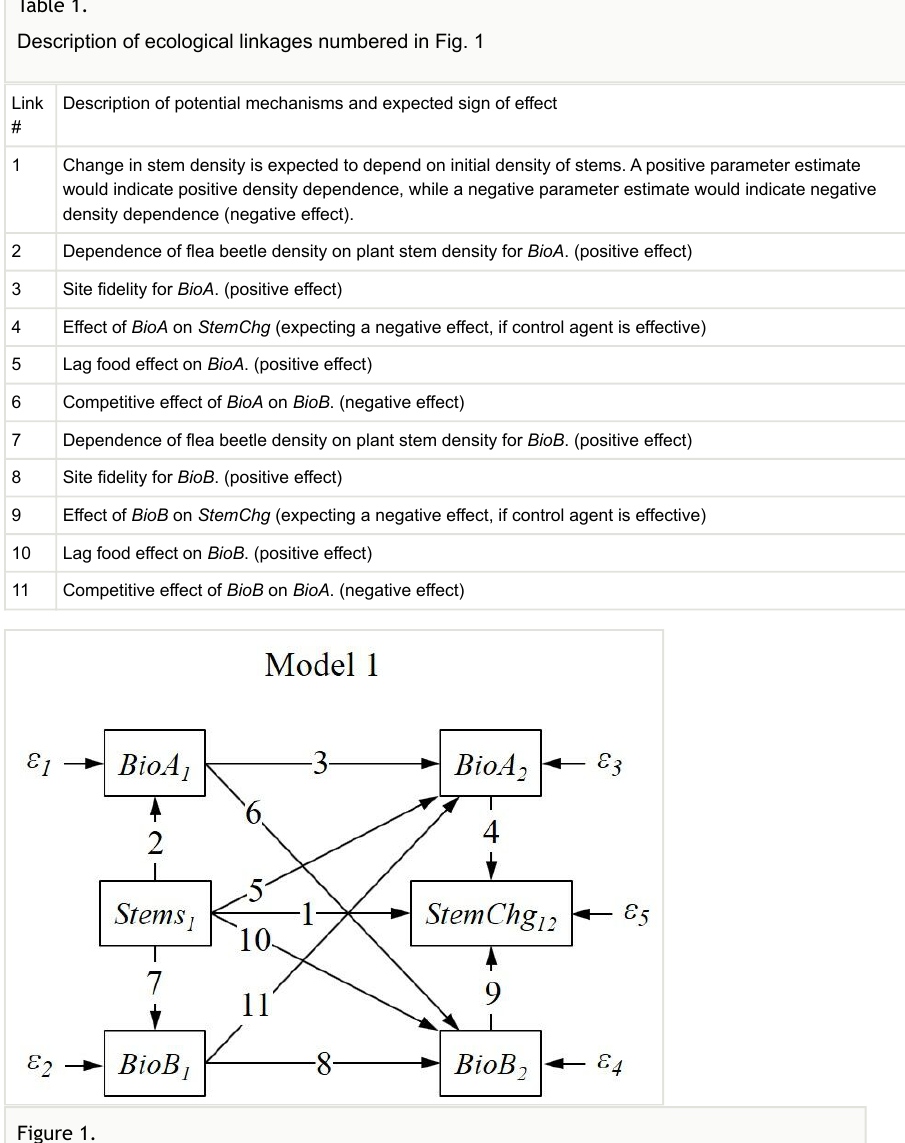
Structural equation model representing an initial hypothesis regarding the potential effects of two biocontrol flea beetles, BioA ( Aphthona nigriscutus ) and BioB ( Aphthona lacertosa ), on an invasive plant ( Euphorbia esula ). Stem and beetle densities were measured over two years and the change in stem density between years 1 and 2 computed ( StemChg12